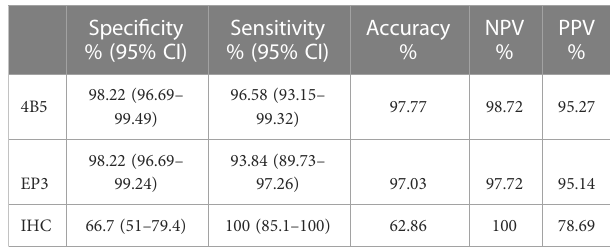
TABLE 2 Sensitivity and speci fi city of Her2 levels from the QDB method using 4B5 and EP3 antibodies, respectively, vs. IHC ( n = 578) using FISH results as the gold